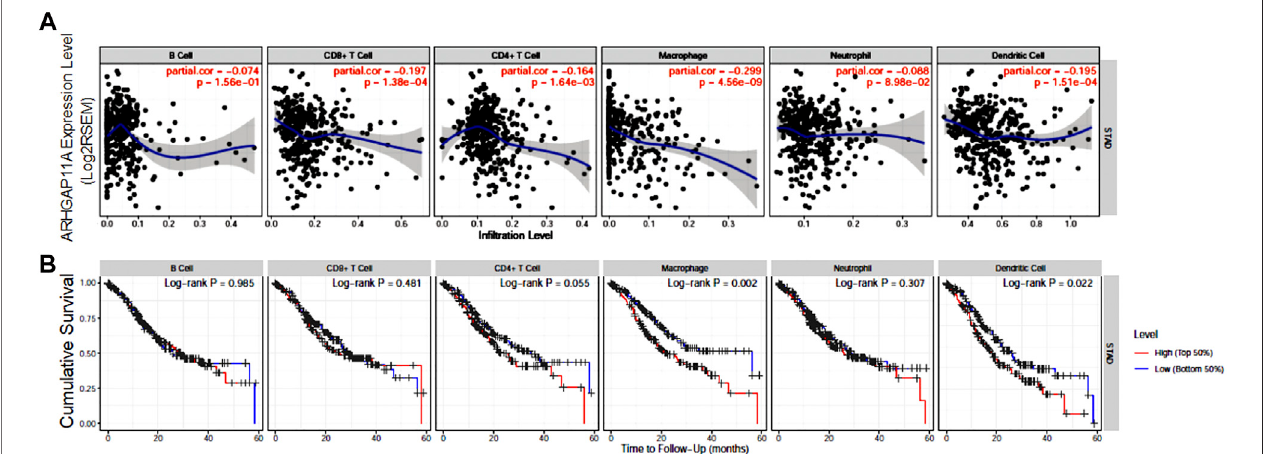
FIGURE3| ARHGAP11A expression iscorrelatedwithimmunein fi ltratesingastriccancer. (A) Correlation ofARHGAP11Aexpression withimmunecellin fi ltration. (B) Prognostic value of immune cell in fi ltration in gastric